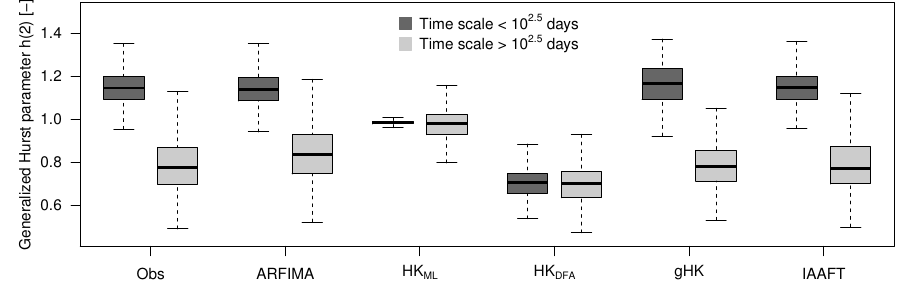
Figure 7. Box plots of the slopes h ( 2 ) of the F 2 ( k ) functions shown in Figure 6 computed for k < 10 2.5 and k < 10 2.5 to highlight the scaling crossover at the time scale k ≈ 10 2.5 . The pairwise scatter plots and the values of the Kendall correlation coefficient τ K in the upper triangular matrix of panels in Figure 8 show that only H gHK and H DFA are correlated. The spatial distribution of the H values (lower triangular matrix of panels in Figure 8) shows that H DFA exhibit a coherent pattern with lower values around the Alpine area and upper Danube, and larger values in the northern part of the study area and lower Danube. Therefore, persistence tends to coherently emerge in lower part of the large rivers flowing in the plain areas of northern Europe and lower Danube, and is less evident in the smaller rivers flowing in the mountainous/hilly areas of southern France, Alps, and upper Danube. The spatial pattern is less evident or lost for H gHK and H ARFIMA as LRD components in these models are influenced by the SRD